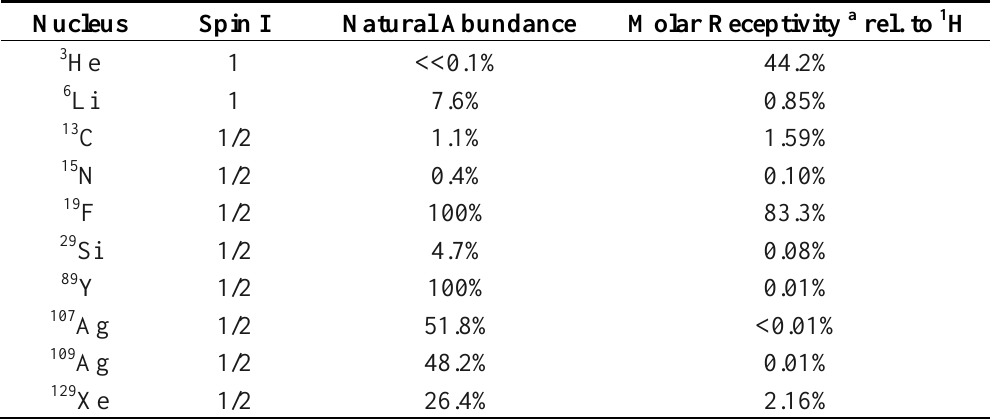
Table 1. Nuclei used in hyperpolarized NMR